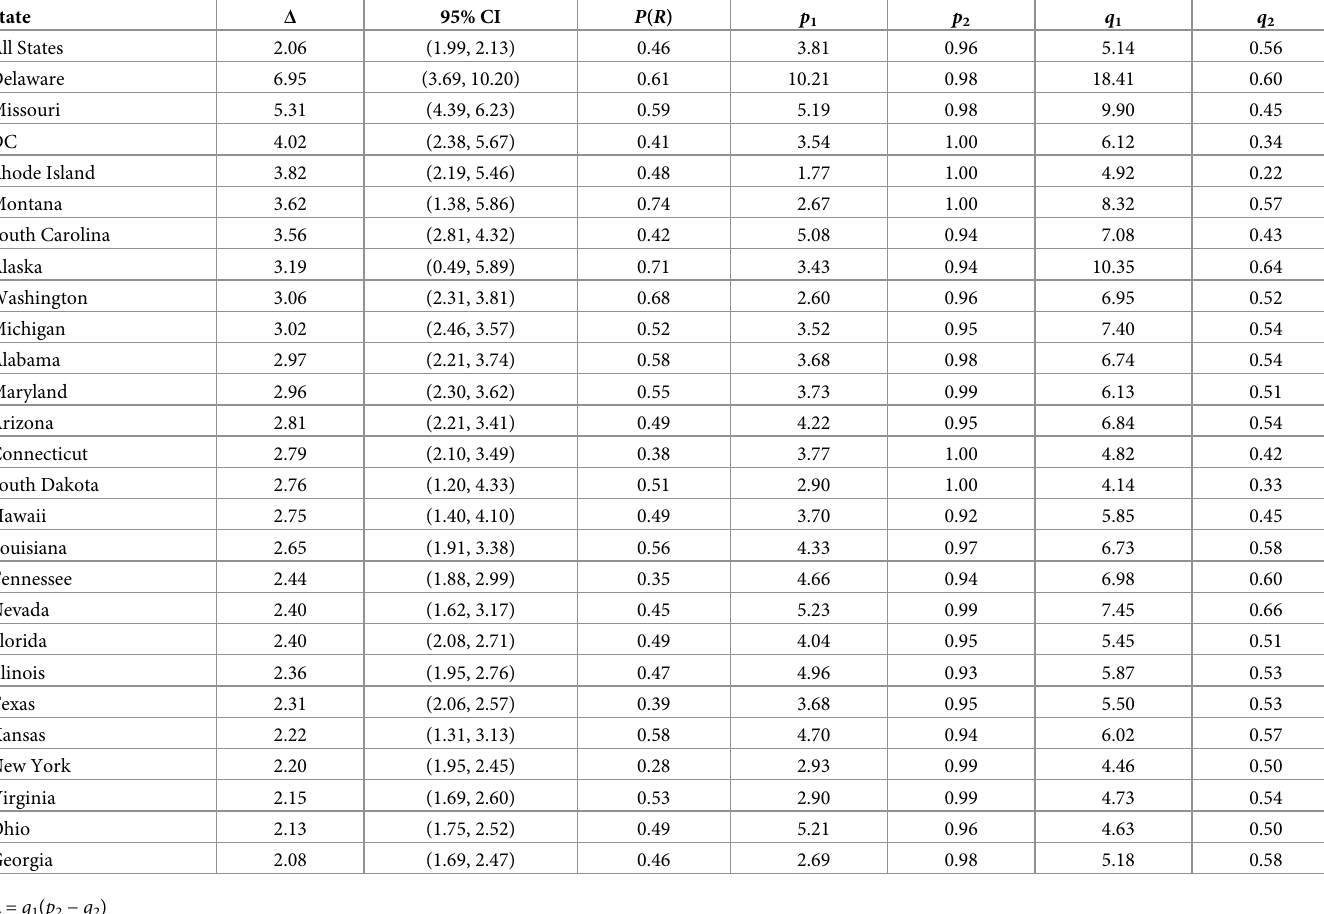
Table 1. 2018 state estimates, part